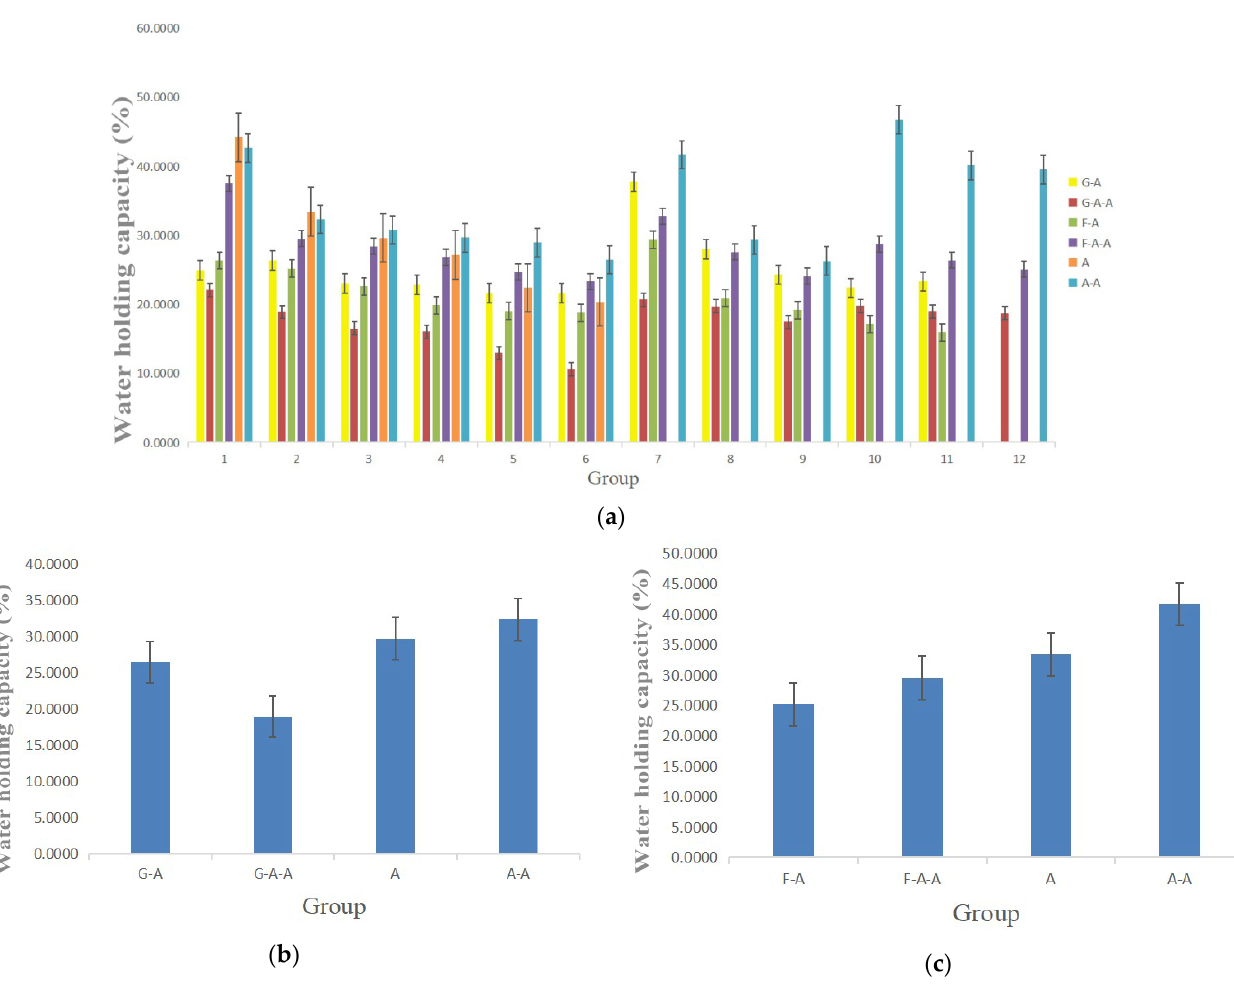
Figure 3. Water holding capacity (WHC) of the alginate-based hydrogels: ( a ) comparison of the WHCs of the G-A, G-A-A, F-A, F-A-A, A and A-A hydrogels prepared in Table 1; ( b ) comparison of the WHCs of the G-A, G-A-A, A and A-A hydrogels prepared in Table 2; ( c ) comparison of the WHCs of the F-A, F-A-A, A and A-A hydrogels prepared in Table 2.